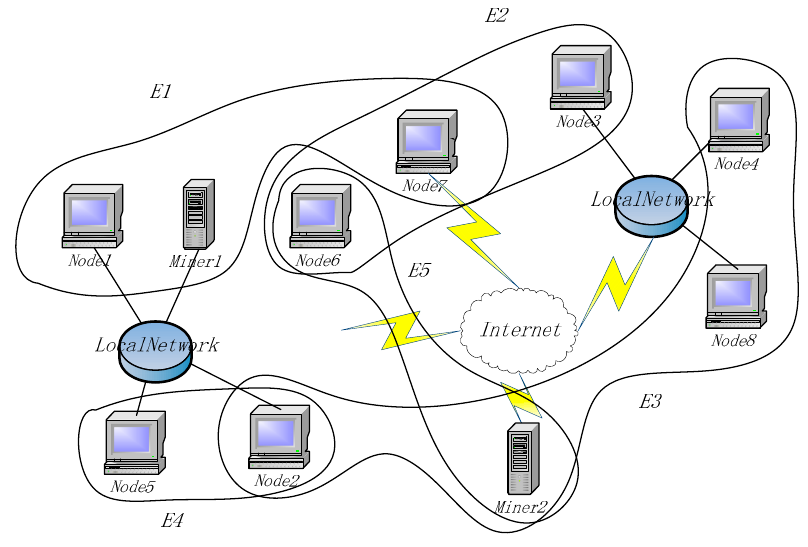
Figure 3. Hypergraph based Blockchain architecture.